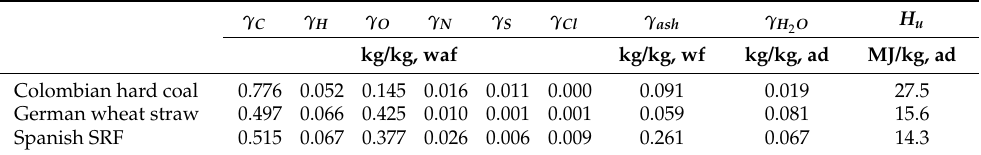
Table 1. Chemical composition ( γ i ) and net calorific value ( H u ) of the utilized fuels (waf: water and ash free; wf: water free; ad: air dried). γ C